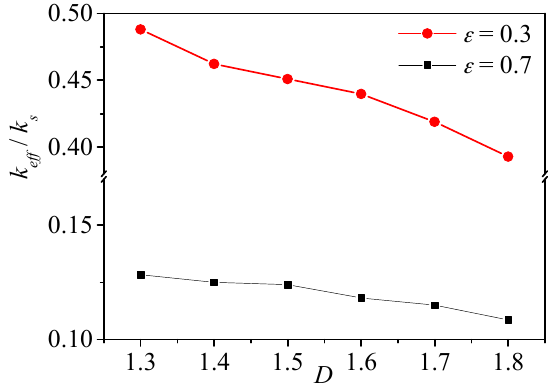
Figure 9. Effect of fractal dimension on the effective thermal conductivity.